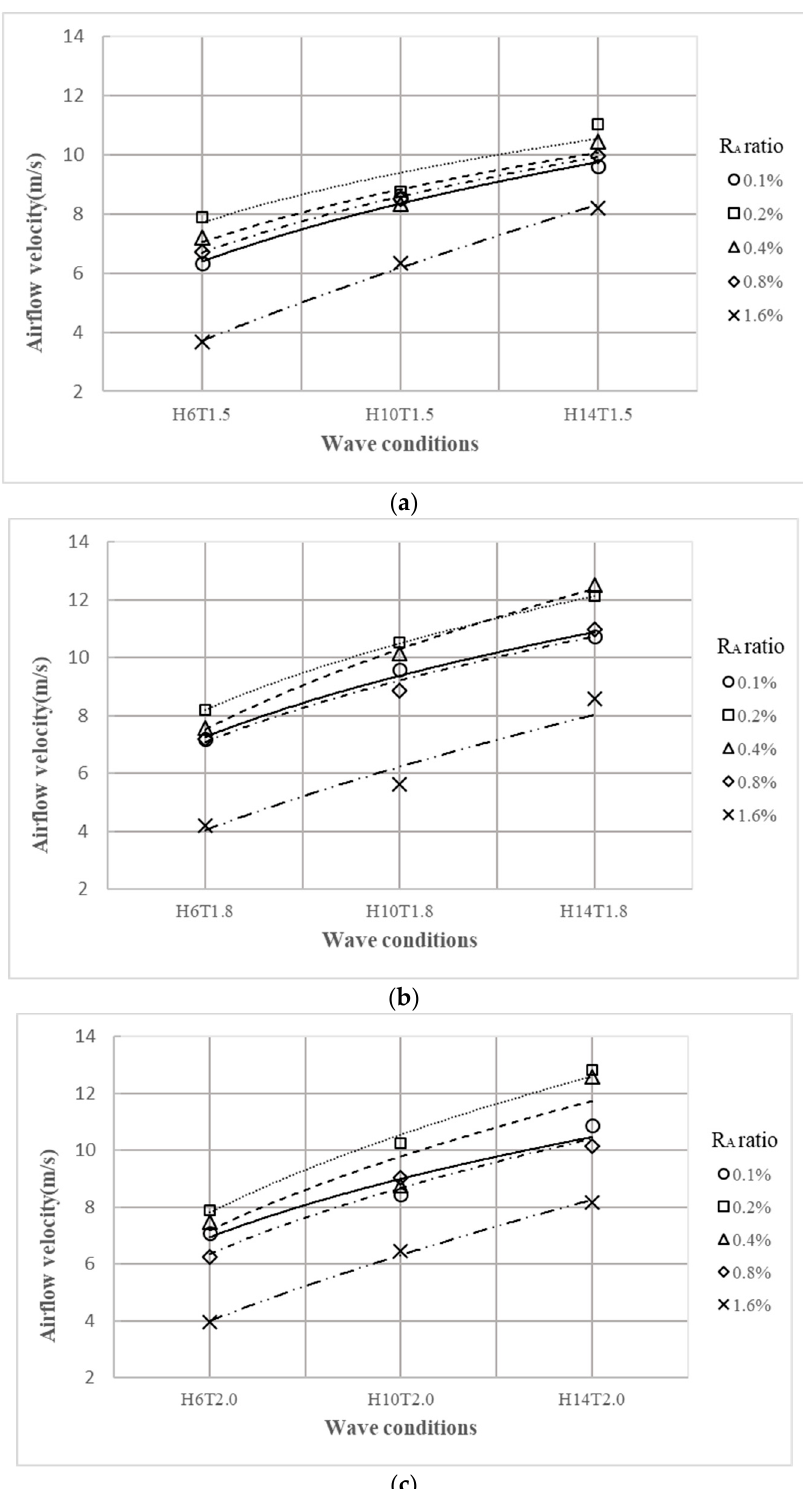
Figure 8. ( a ) Velocity of airflow for various wave heights (T = 1.5 s, R Z = 0.5); ( b ) Velocity of air flow for various wave heights (T = 1.8 s, R Z = 0.5); ( c ) Velocity of air flow for various wave heights (T = 2.0 s, R Z = 0.5).